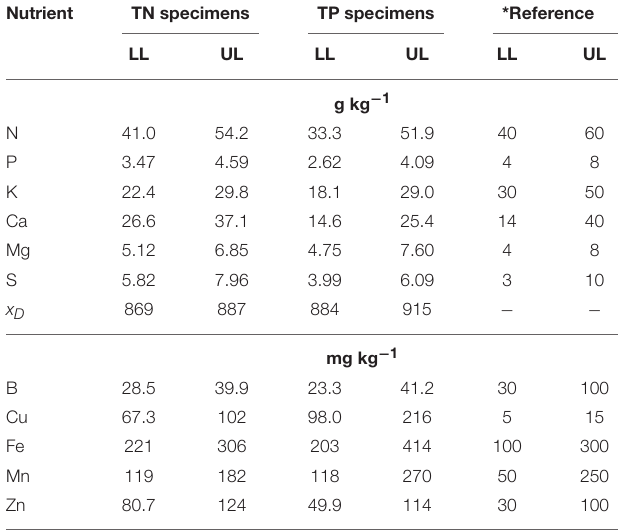
TABLE 6 | Confidence intervals for true negative (TN) and true positive (TP) tomato crops about the isometric log ratio (ilr) means, back-transformed to concentration